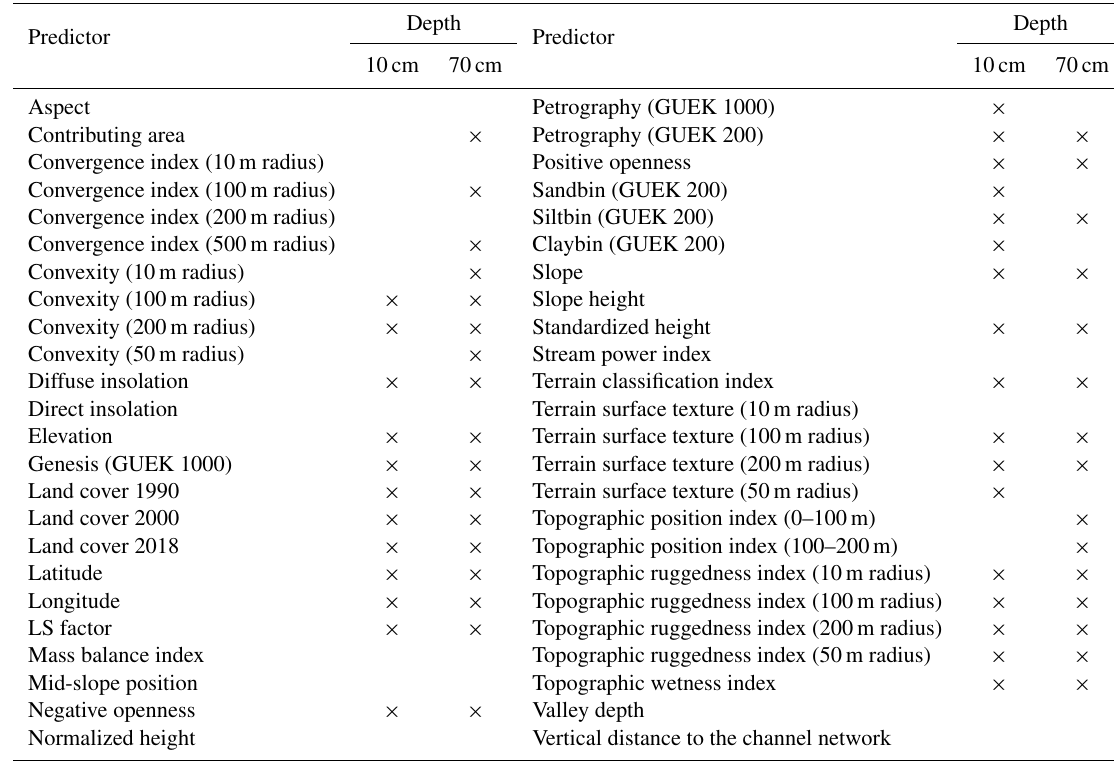
Table 2. Predictors included in the random forest model for 10 and 70cm depth, denoted by “ ×